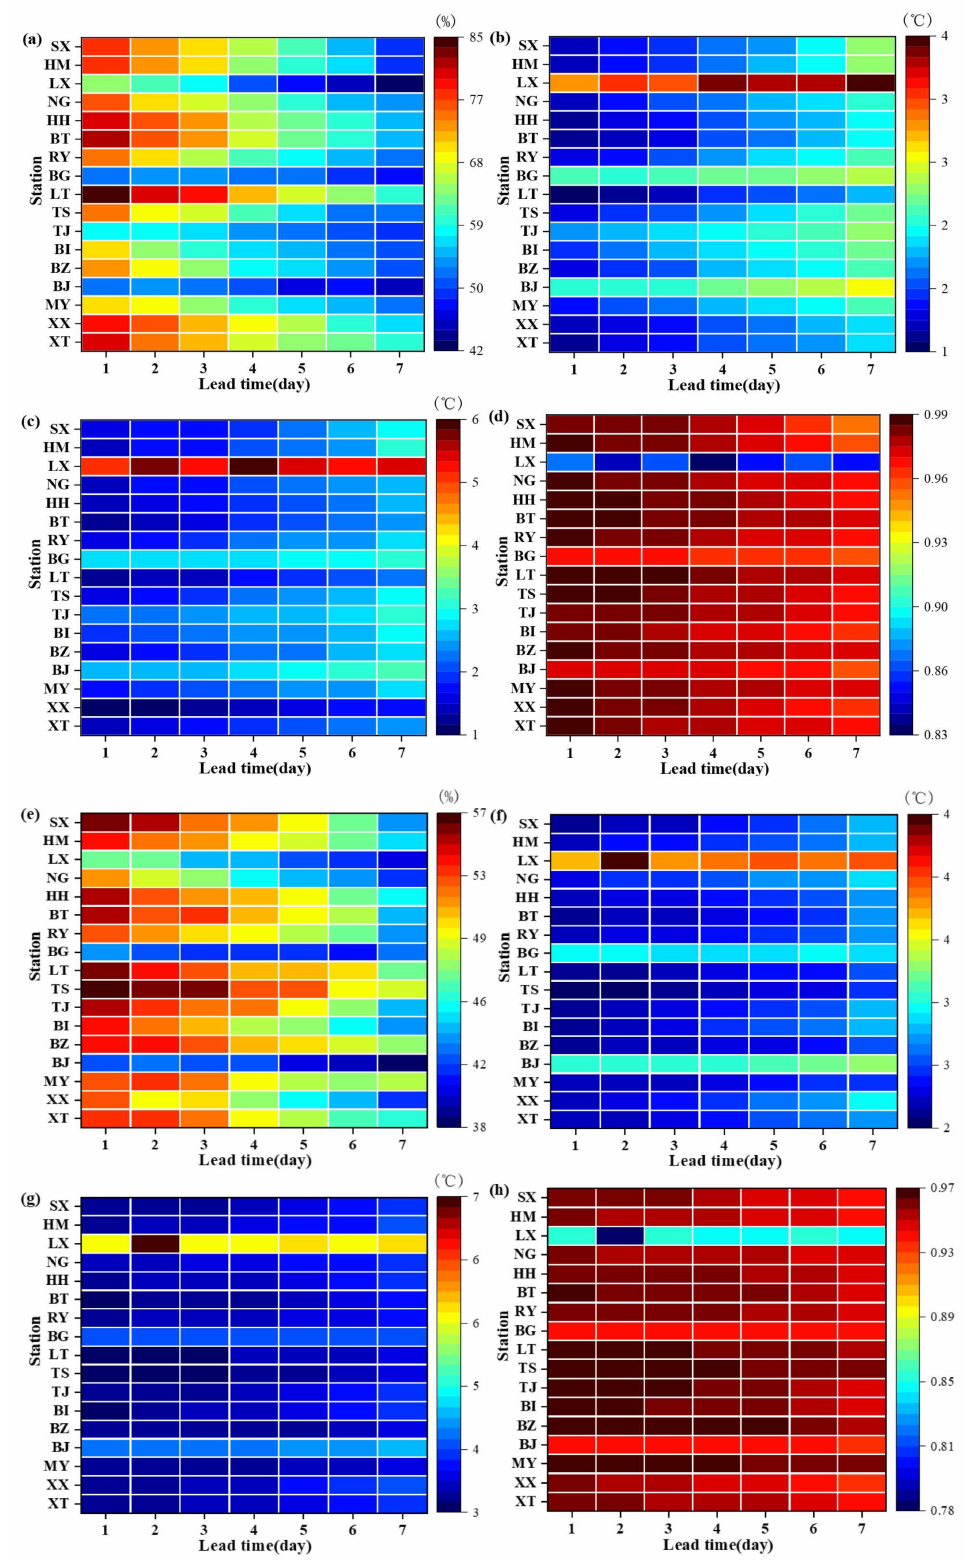
Figure 3. Statistical indices for daily minimum temperature forecasts: ( a ) Accuracy, ( b ) MAE, ( c ) RMSE, and ( d ) R; for daily maximum temperature forecasts: ( e ) Accuracy, ( f ) MAE, ( g ) RMSE, and ( h ) R at 17